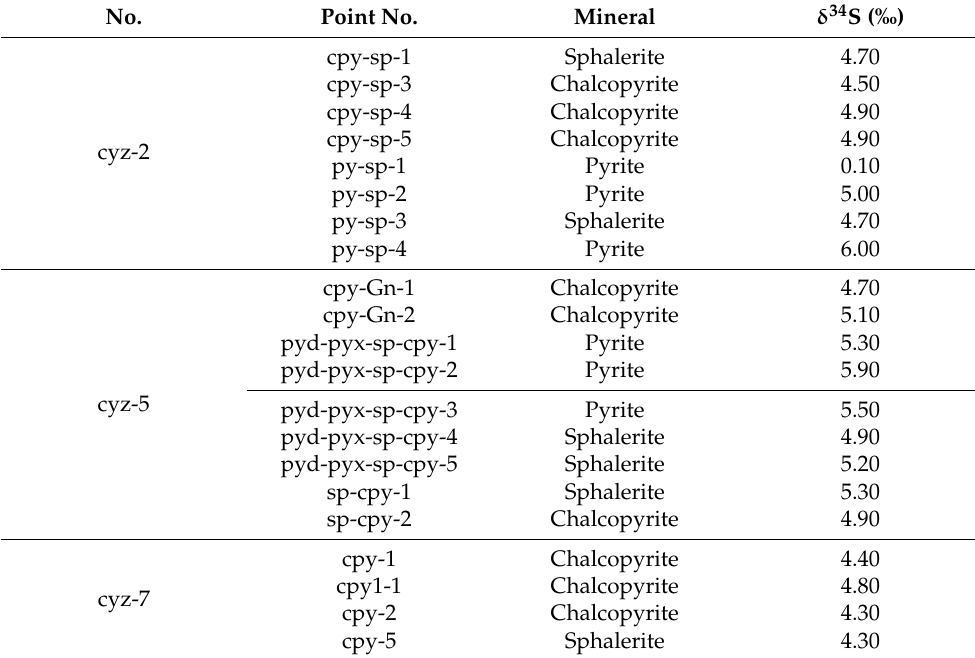
Table 2. In situ sulfur isotopic compositions of ore sulfides.